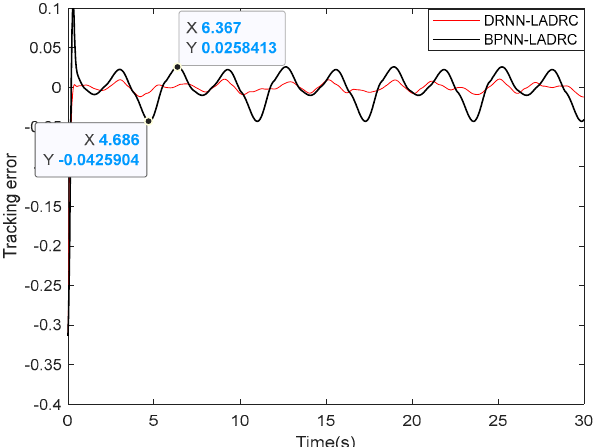
Figure 16. Tracking outputs of the DRNN-LADRC and BPNN-LADRC for the radar system.